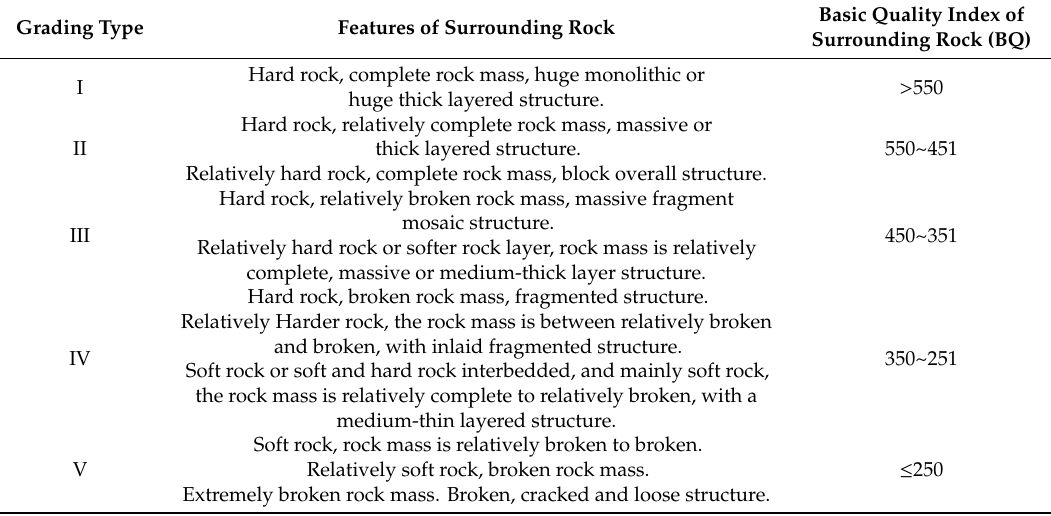
Table 1. Grading for surrounding rock of highway